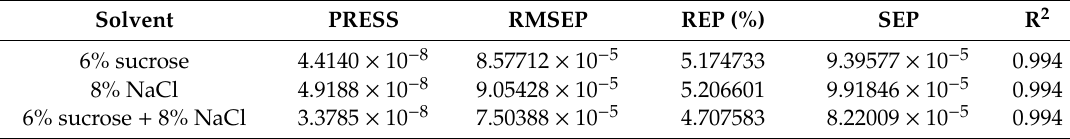
Table 6. Results of statistical parameters of the simplified Apelblat